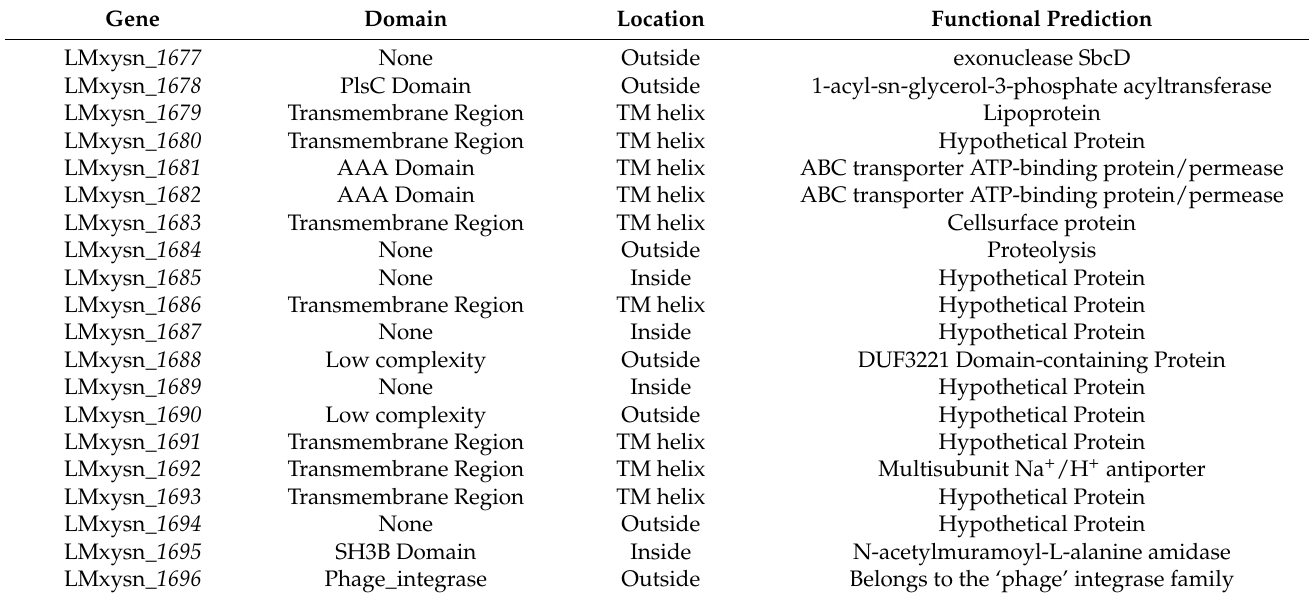
Table 1. Predictions the function of genes in GI-7.